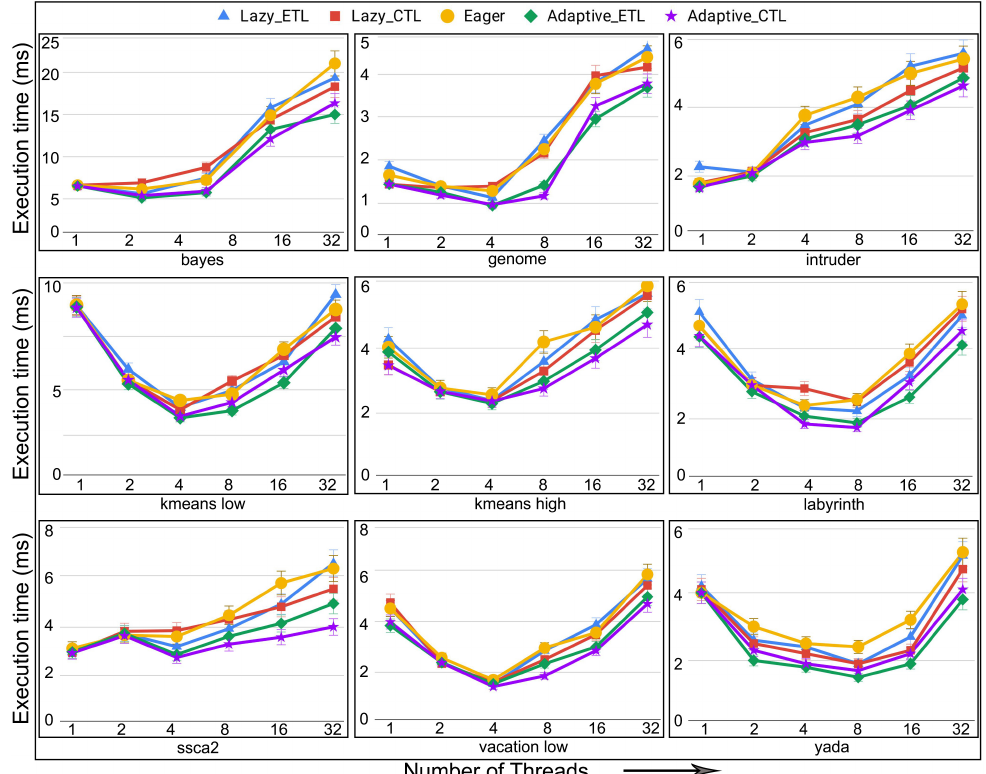
Figure 23. Execution time in STAMPEDE benchmarks using better time barrier in non-persistent